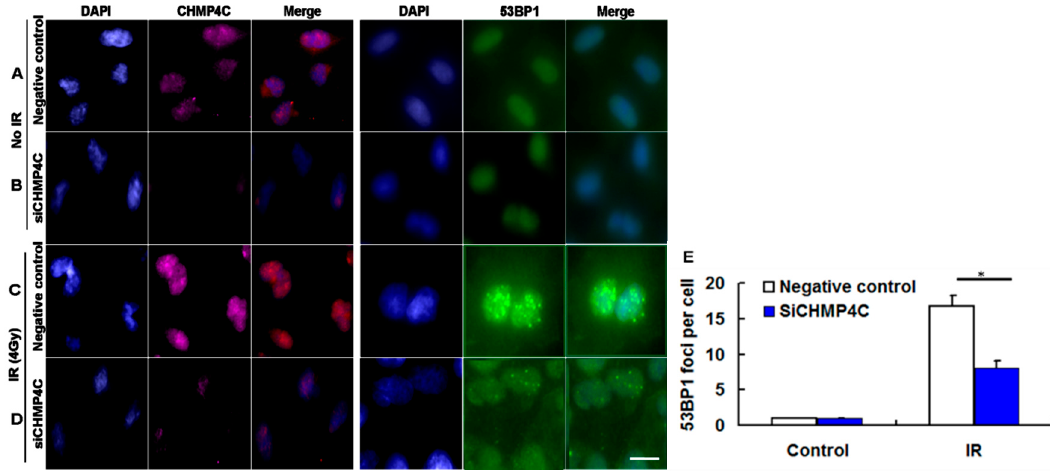
Figure 8. CHMP4C abrogation represses IR-induced 53BP1 foci formation. ( A , B ) Negative control or siCHMP4C transfected cells without IR; ( C , D ) A549 infected with negative control or siCHMP4C were then treated with 4 Gy radiation; and ( E ) image of 53BP1 foci formation. The number of foci per nucleus was quantitated. The data are presented as the mean ± S.E. of three independent experiments, * p < 0.05. Scale bar, 10 µm.